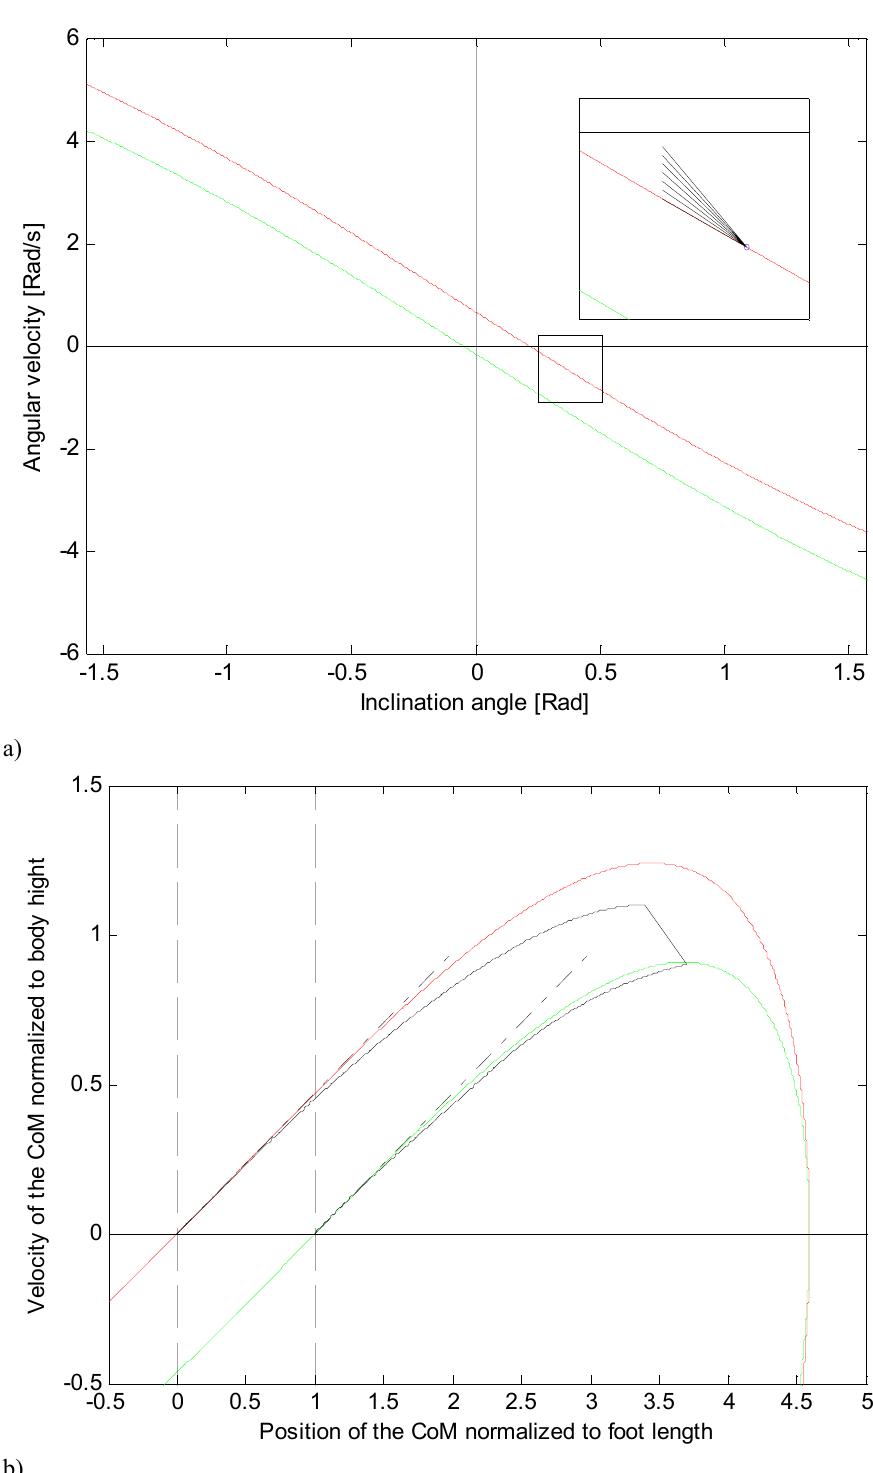
Figure 2. a) Stable subspaces corresponding to the maximum torque in dorsiflexion (green curve) and plantar flexion (red curve) directions, in the angle-angular velocity ( (cid:2206) ) plane. The area between the two curves is balanceable. The criterion of Theorem 3 is checked and confirmed. As an example, (cid:1858)(cid:4666)(cid:2206), (cid:2203)(cid:4667) at one state (cid:2206) (cid:3404) (cid:4670)0.439 (cid:3398) 0.676(cid:4671) (cid:3021) for all (cid:1873) (cid:1488) (cid:2287) is shown. b) Boundaries of the balanceable region mapped in the (cid:2208) -plane (green and red curves), and those obtained in [5] (solid black) and in [8] (dash-dotted